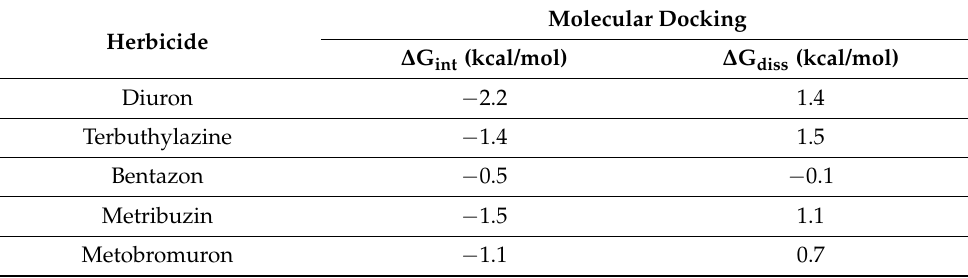
Table 3. Values of solvation free energy ( ∆ G int ) and free energy of assembly dissociation ( ∆ G diss ) of the most stable protein-herbicide models obtained by molecular docking simulations. Molecular Docking Herbicide ∆ G ∆ G int (kcal/mol) diss (kcal/mol) Diuron − 2.2 1.4 Terbuthylazine − 1.4 1.5 Bentazon − 0.5 − 0.1 Metribuzin − 1.5 1.1 Metobromuron − 1.1